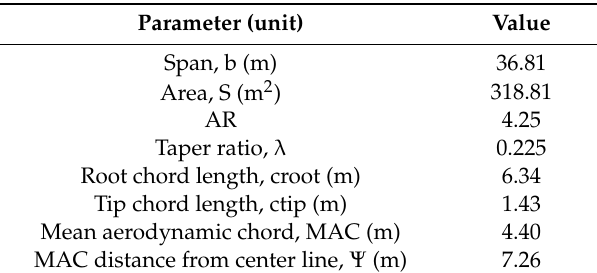
Table 3. Wing geometry.